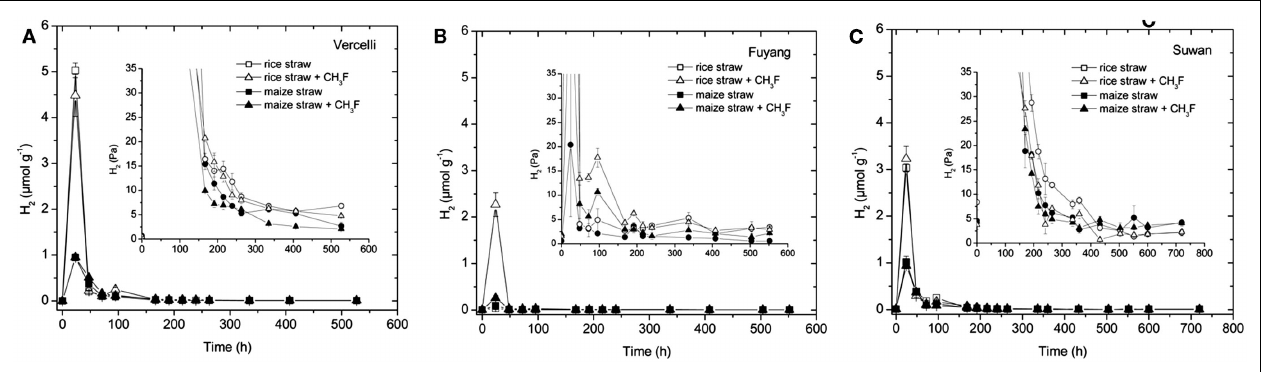
CH 3 F (1, 2, and 2% inVercelli, Fuyang, and Suwan soil, respectively); mean ± SE, n = 3. The insert shows the H 2 accumulated in units of partial pressure (Pa).